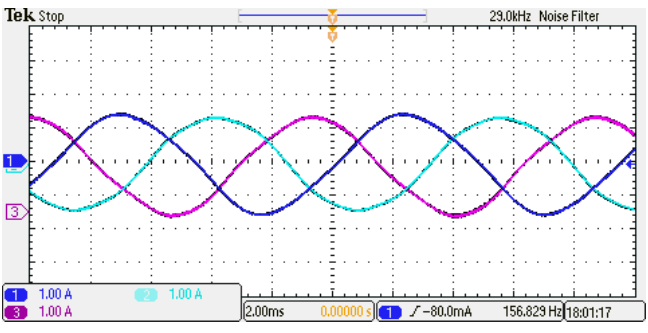
Figure 4. The overall control diagram of SCLC mode for the constant speed control.